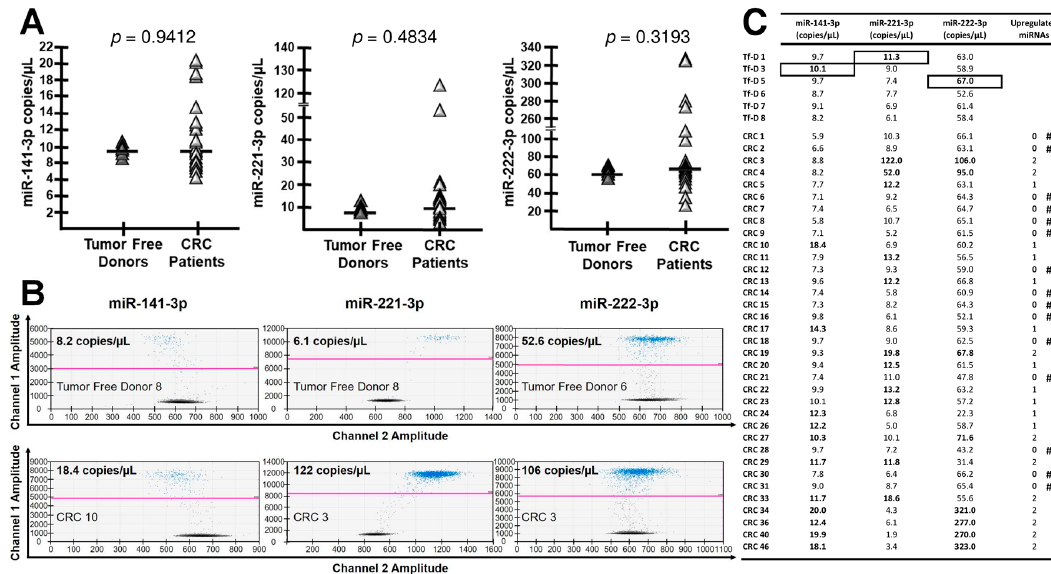
Figure 1. Digital Droplet RT-PCR (dd-RT-PCR) of miR-141, miR-221 and miR-222 in CRC patients. ( A ): Plasma samples from 35 CRC patients (CRC) and 6 tumor-free donors (Tf-D) were assessed by dd-RT-PCR. Representative plots are depicted in panel ( B ) and a summary in panel ( C ). ( C ): the highest values in Tf-D control samples are black boxed, and denote up-regulation in the CRC samples compared to the highest control. The number of up-regulated miRNAs in CRC patients (indicated in bold) is noted. # = no miRNA up-regulation.